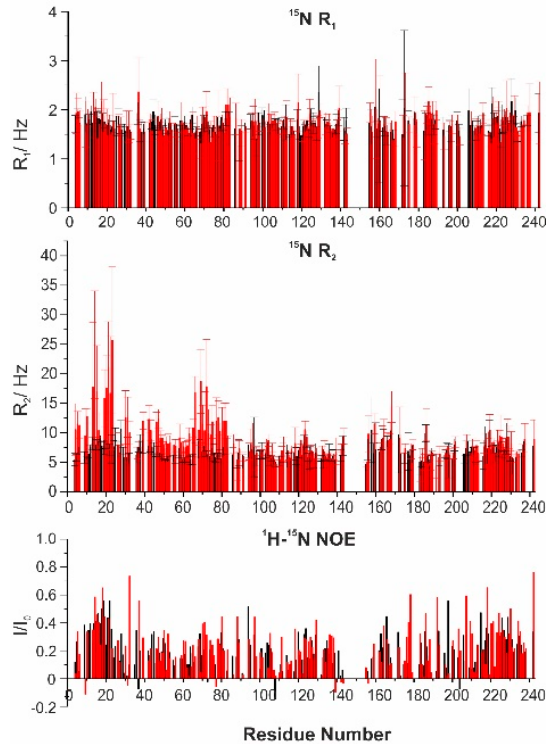
Figure 5. Nuclear relaxation data for the backbone amide 15 N obtained for E1A12S (black) and the 1:1 complex E1A12S:CBP-ID4 (red). From top to bottom, 15 N longitudinal relaxation rates (R 1 , Hz), 15 N transverse relaxation rates (R 2 , Hz) and 1 H- 15 N NOE values. In the plot, the missing data derive from residues that are not observable or not resolved.